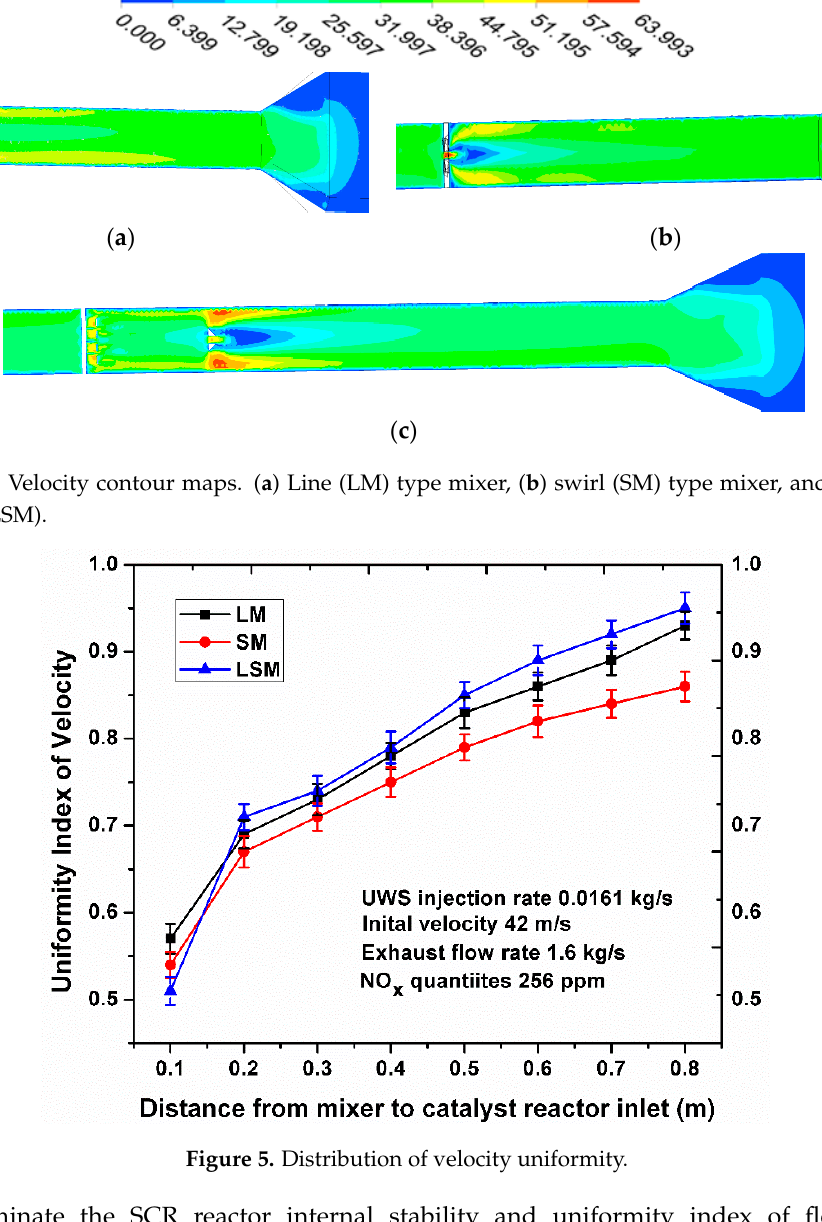
Figure 4. Velocity contour maps. ( a ) Line (LM) type mixer, ( b ) swirl (SM) type mixer, and( c ) two mixers (LSM).